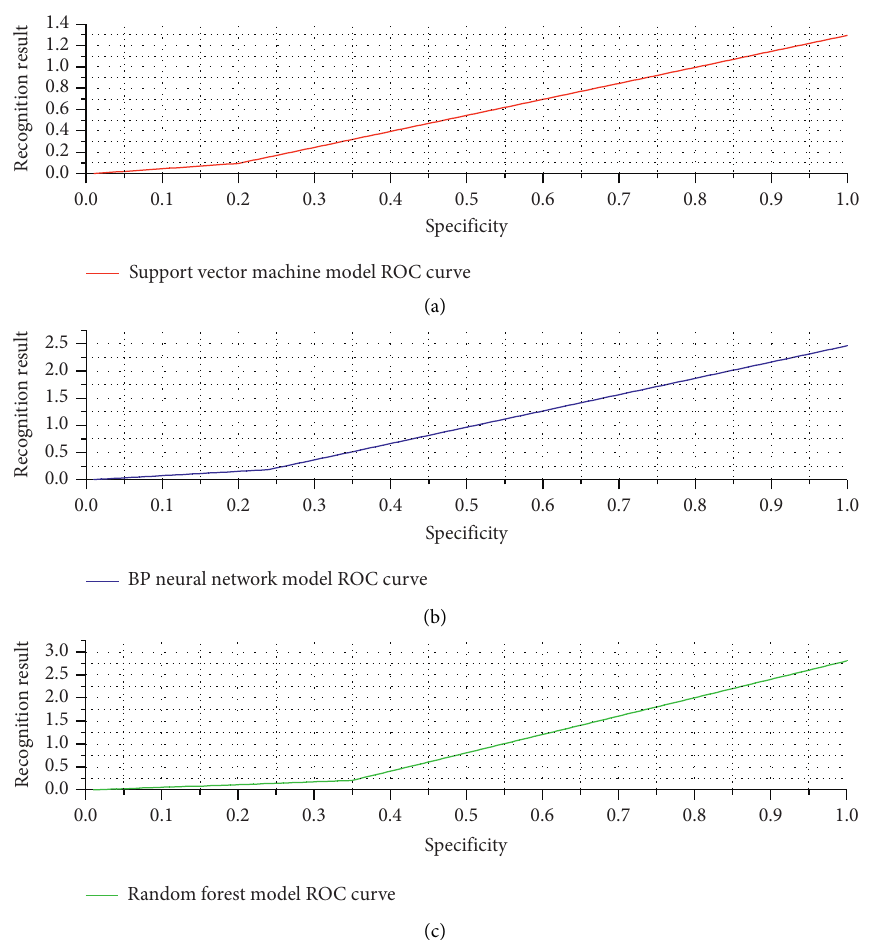
Figure 8: Receiver operating characteristic (ROC)